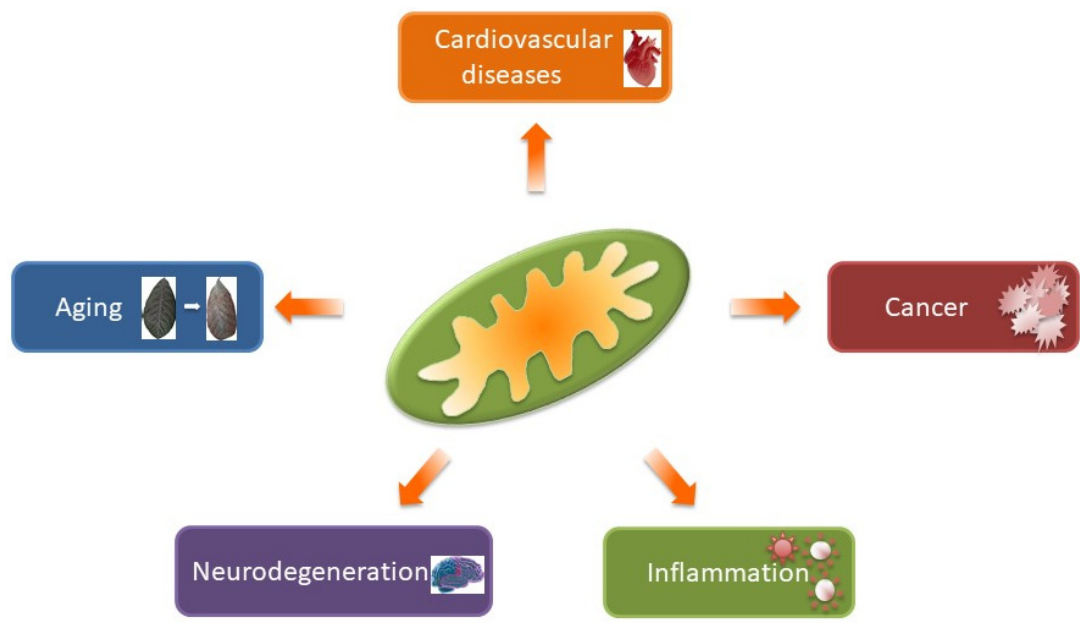
Figure 1. Involvement of mitochondria in different pathological conditions.